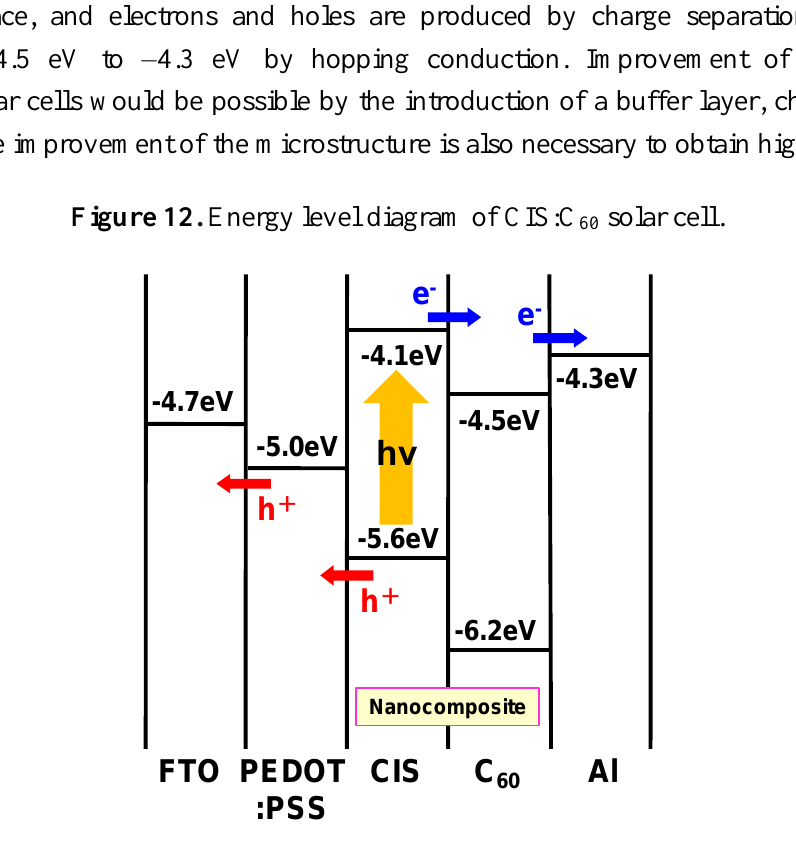
Figure 12. Energy level diagram of CIS:C